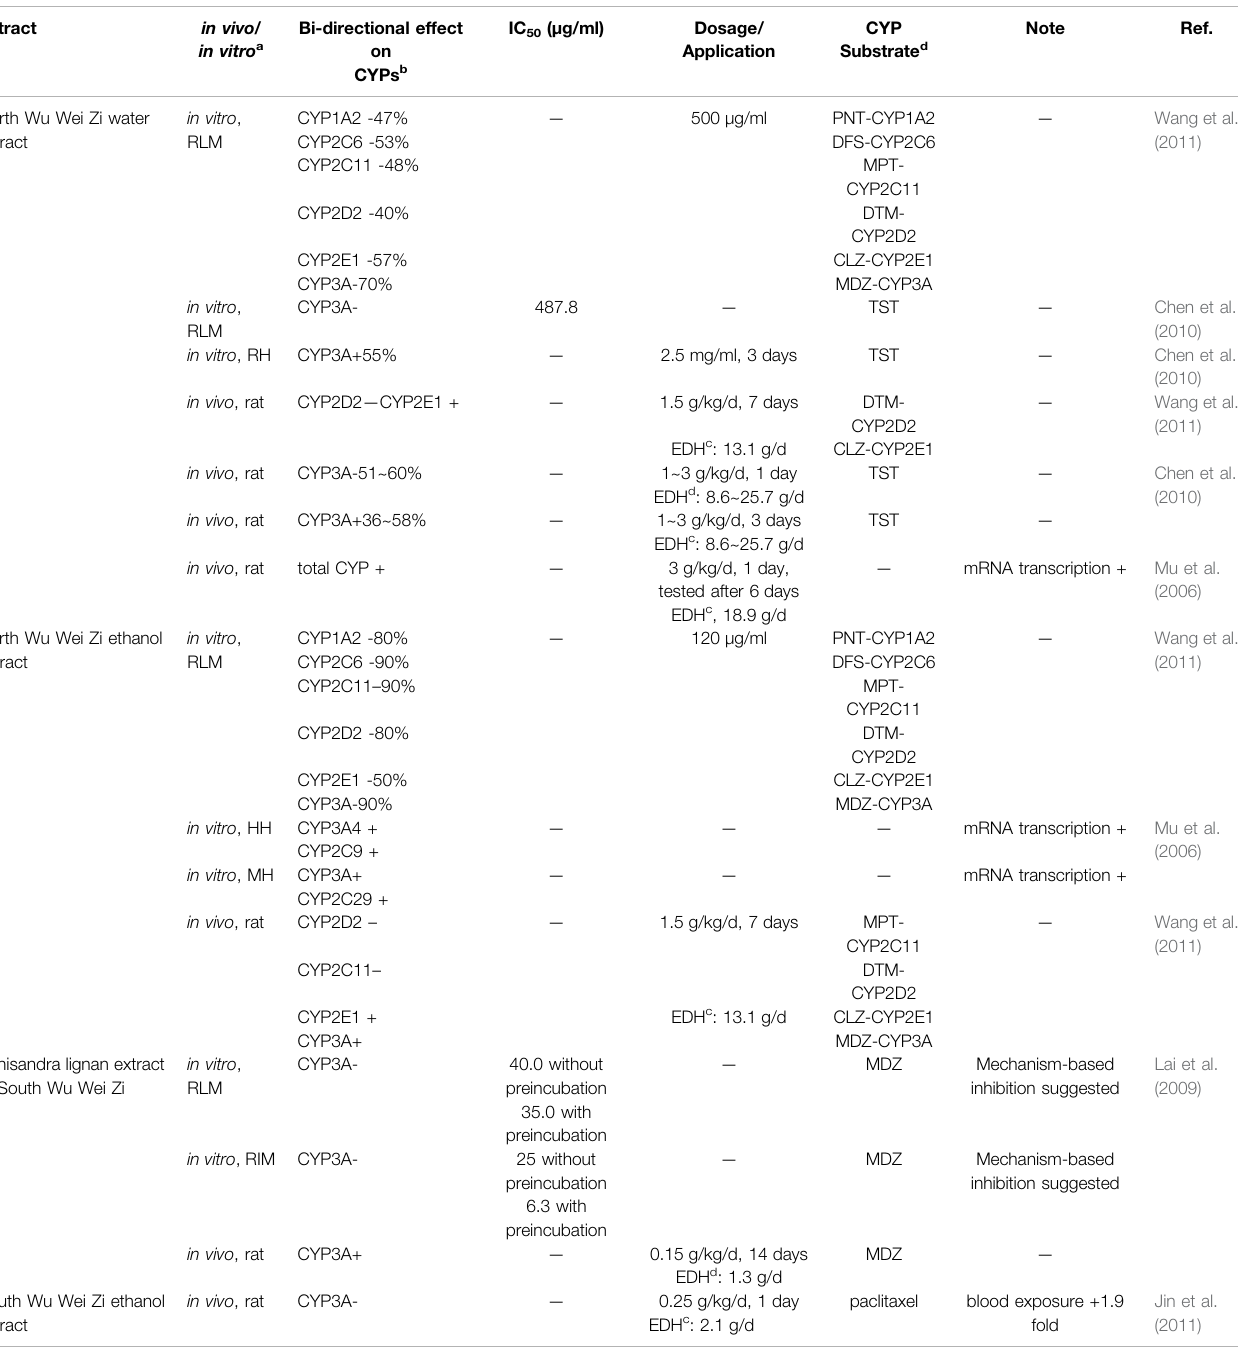
TABLE 2 | Biphasic effect on regulating CYP activities by Wu Wei Zi extract.